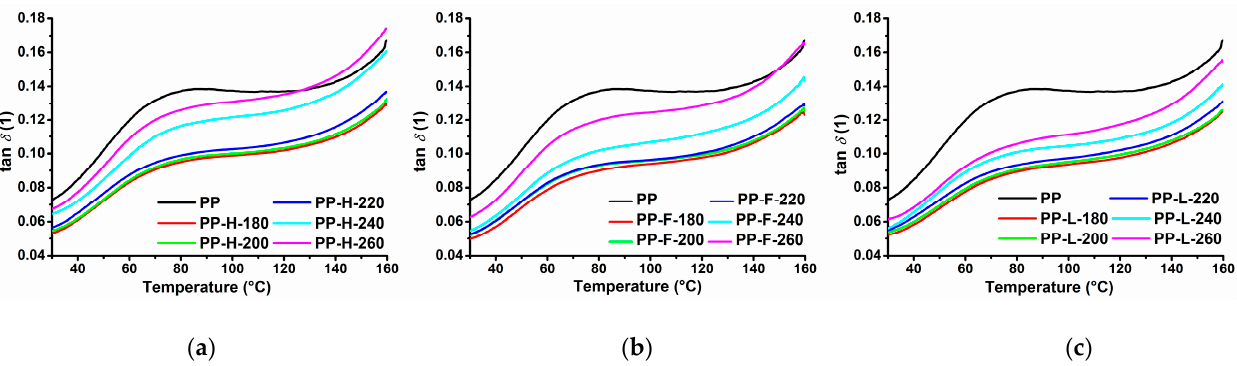
Figure 8. Damping factor as a function of the temperature of composites processed at different temperatures: ( a ) PP/hemp; ( b ) PP/flax; ( c ) PP/Lyocell.